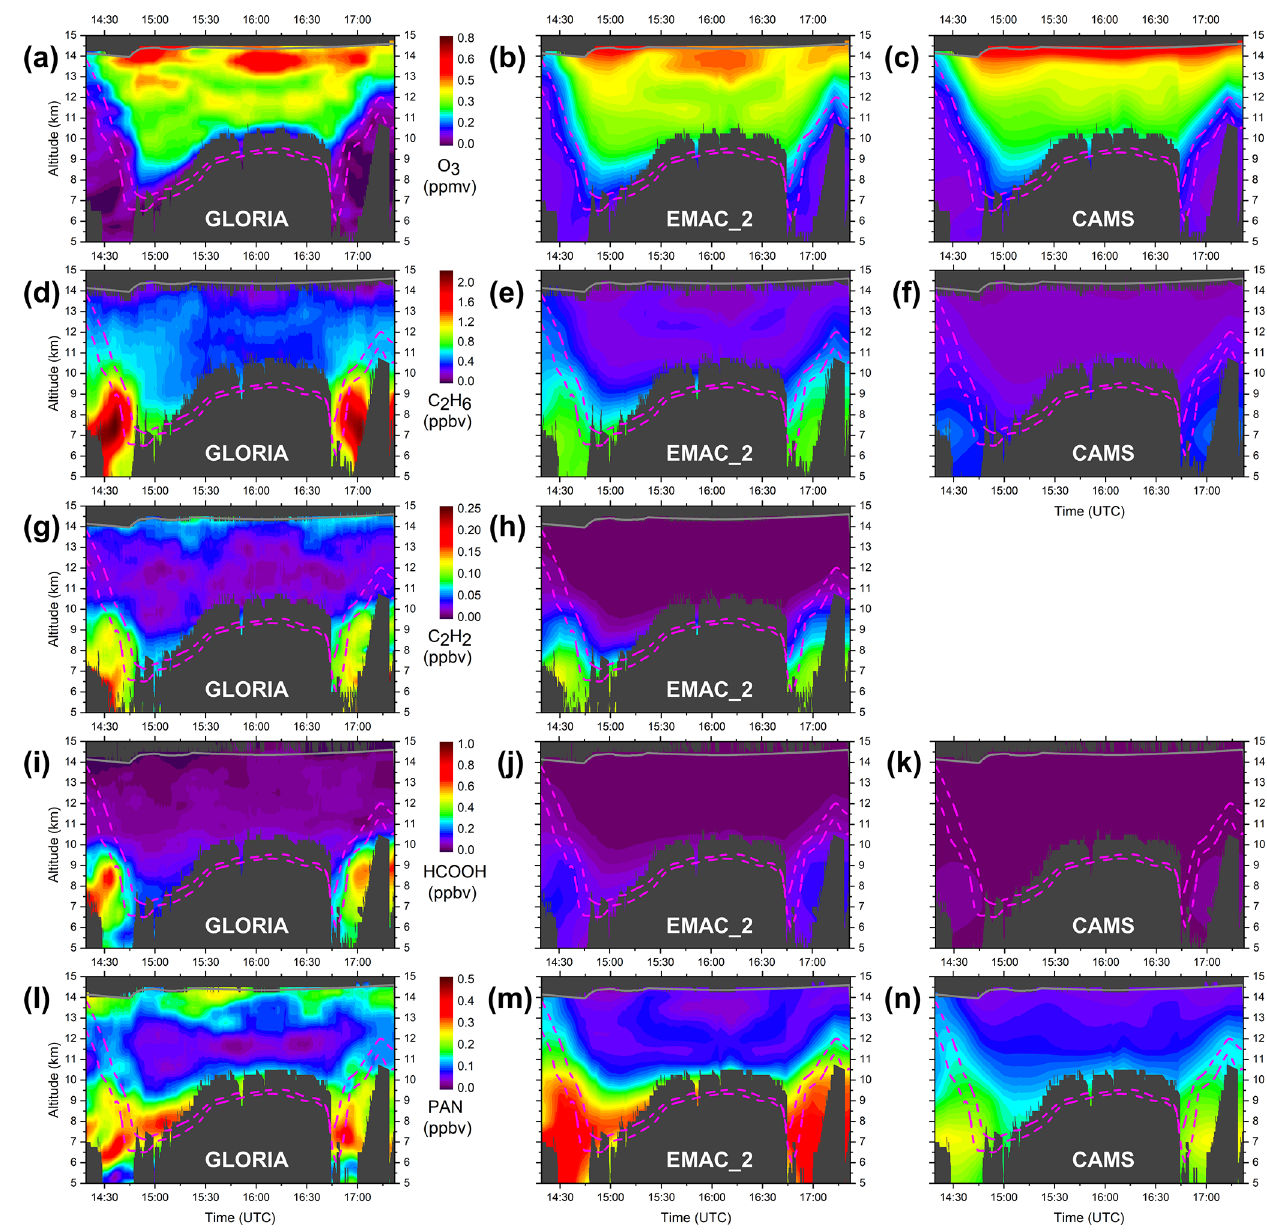
Figure 7. Horizontal and vertical VMR distributions of GLORIA (repeated from Fig. 6 but temporally smoothed, left column), EMAC_2 (middle column), and CAMS (right column) of (a–c) O 3 , (d–f) C 2 H 6 , (g–h) C 2 H 2 , (i–k) HCOOH, and (l–n) PAN, as seen on 13 Septem- ber 2017. The EMAC_2 simulation includes NMVOC emissions enhanced by a factor of 2 as recommended by Monks et al. (2018). No CAMS data for C 2 H 2 are available. Annotation as per Fig.